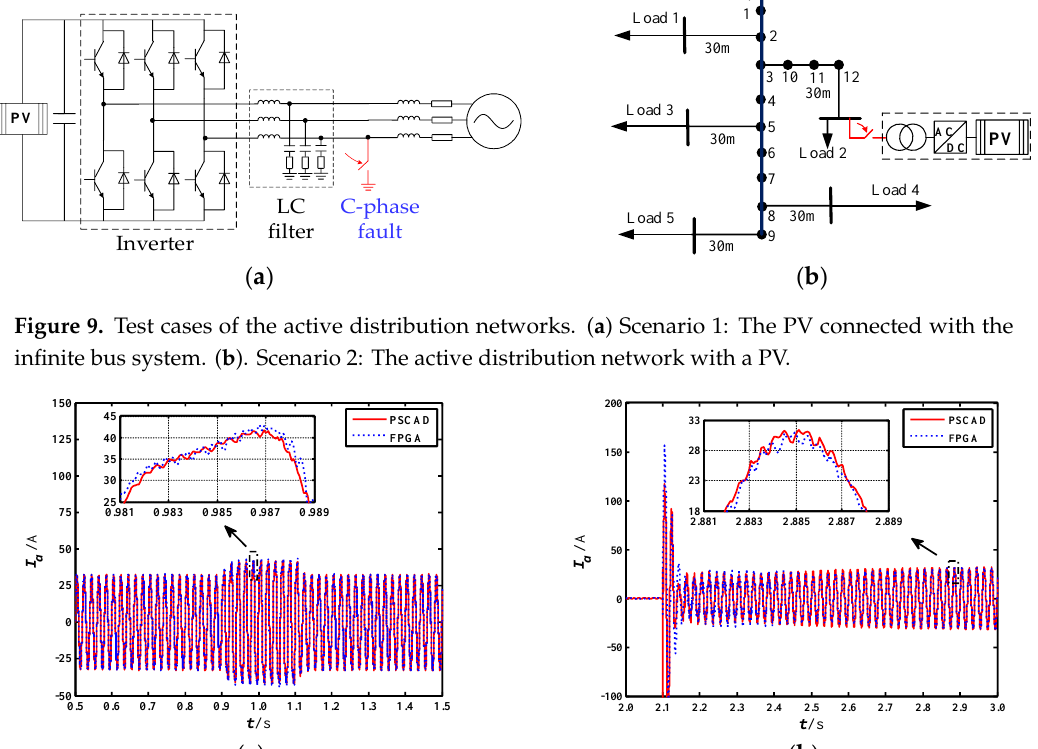
Figure 10. Comparison of the simulation results between the FPGA-based real-time simulator and PSCAD / EMTDC. ( a ) A phase current I a of the grid-connected point of the PV in Scenario 1. ( b ) A phase current I a of the grid-connected point of the PV in Scenario 2.